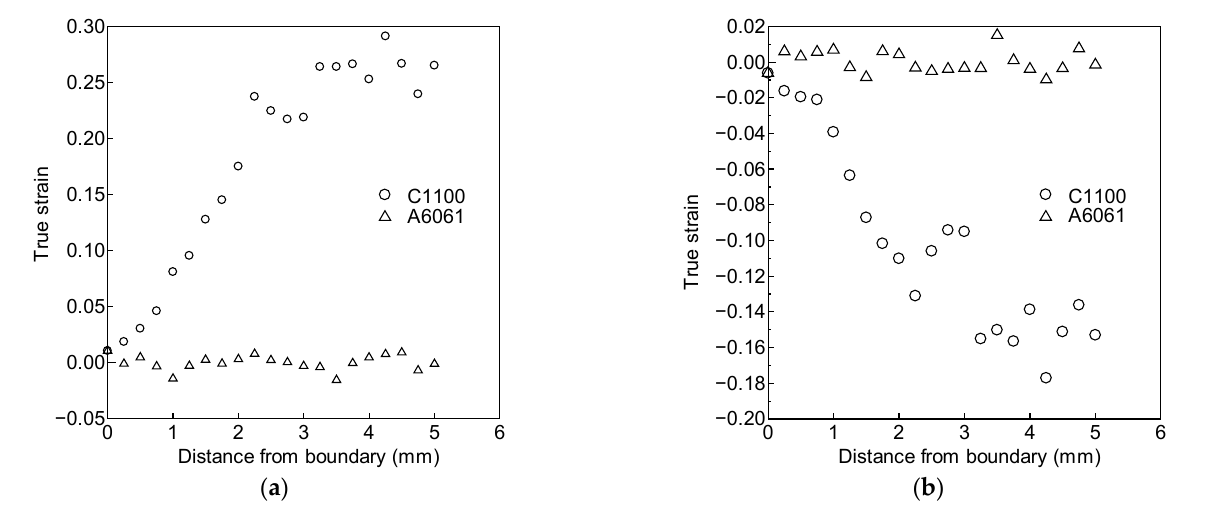
Figure 19. Strain distribution at maximum load point: ( a ) Longitudinal direction; ( b ) Thickness direction.